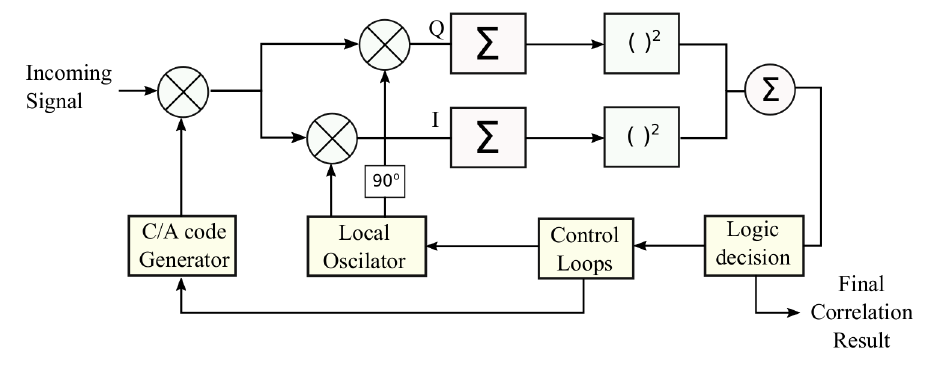
Figure 1. Conventional Acquisition